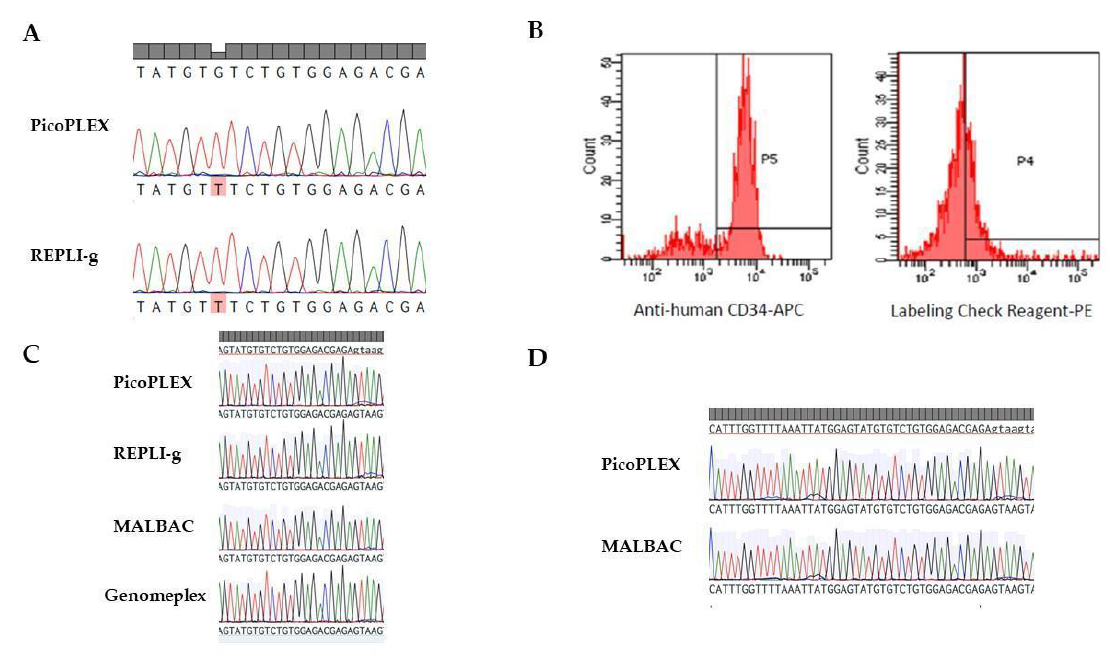
Figure 3. Assays of alternative cells fixation methods. ( A ) Two representative sequences of JAK2 gene coming from unfixed HEL cells whose genome was amplified through either RepliG or PicoPLEX WGA kit ( n = 20 for each kit). In all cells, the homozygous JAK2 c.1849G > T carried by HEL cells was detected. ( B ) CD34 + CD38 + cells fixed with MetOH 100% for 2 h. Flow cytometry analysis shows that MetOH fixation preserves APC fluorochrome but decreases PE signal. The labeling check reagent-PE identifies CD38 expression. ( C ) CD34 + CD38 + cells fixed with 100% MetOH for 2 h at 4 ◦ C. Single-cell WGAs were obtained with PicoPlex, RepliG, GenomePlex and MALBAC kits ( n = 20 for each kit). Electropherograms represent the analysis of a sequence of JAK2 gene. ( D ) CD34 + CD38 + cells fixed with 0.5% PFA for 15 min. Single-cell WGAs were obtained with PicoPlex and MALBAC kits ( n = 20 for each kit). Electropherograms represent the analysis of a sequence of JAK2 gene.